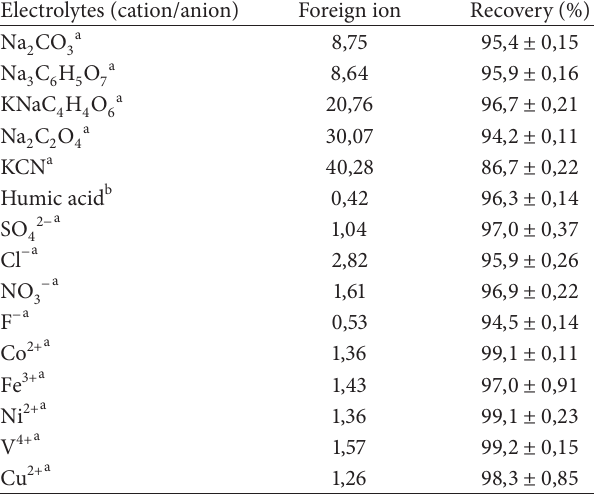
Table 9: Effects of different electrolytes on the retention of Hg(II) ions.